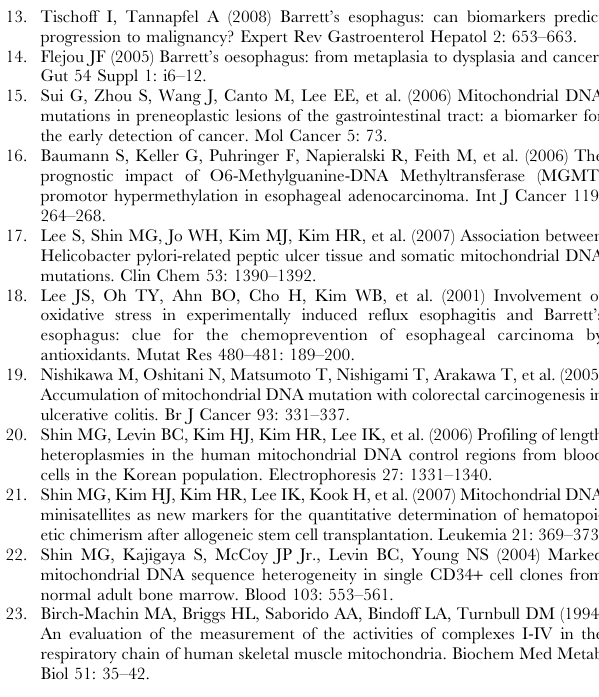
Table S1 Age and sex distribution of subjects. Table S2 Primers for mtDNA control region PCR, direct sequencing, and gene scan. Table S3 Respiratory chain complex I- IV activities in primary Barrett’s metaplasia tissues and